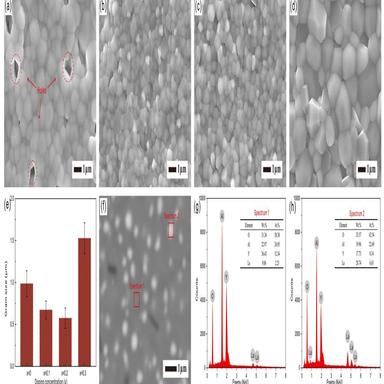
Secondary electron SEM images of the surface morphology of (Y1-xLax)3Al5O12 samples: (a) x = 0, (b) x = 0.1, (c) x = 0.2, (d) x = 0.3, (e) relationship between the La3+ doping concentration and grain size of (Y1- xLax)3Al5O12 (x = 0, 0.1, 0.2, 0.3) samples, (f) backscattered SEM image of the surface morphology of the (Y0.9La0.1)3Al5O12 sample, (g) EDS analysis of the darker phase (spectrum 1), (h) EDS analysis of the lighter granular phase (spectrum 2).